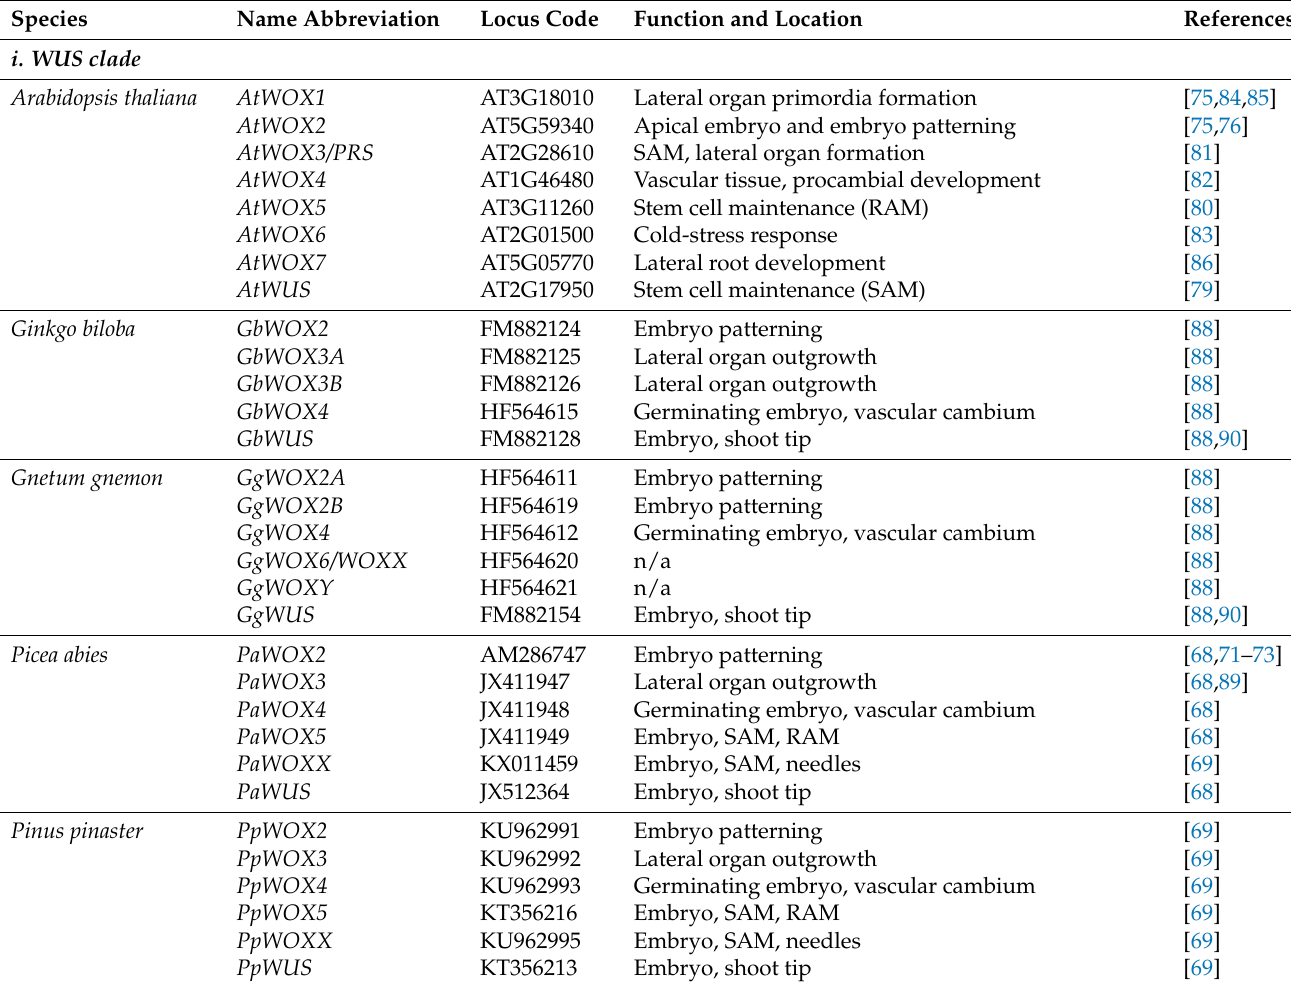
Table 1. List of genes belonging to the WUSCHEL-RELATED HOMEOBOX ( WOX ) family, including those from model species Arabidopsis thaliana and their homologue genes already identified in gymnosperms, with name abbreviation, locus code (AGI code in case of Arabidopsis thaliana , GenBank number in case of gymnosperm species), function, location and references. Shoot apical meristem, SAM; root apical meristem,